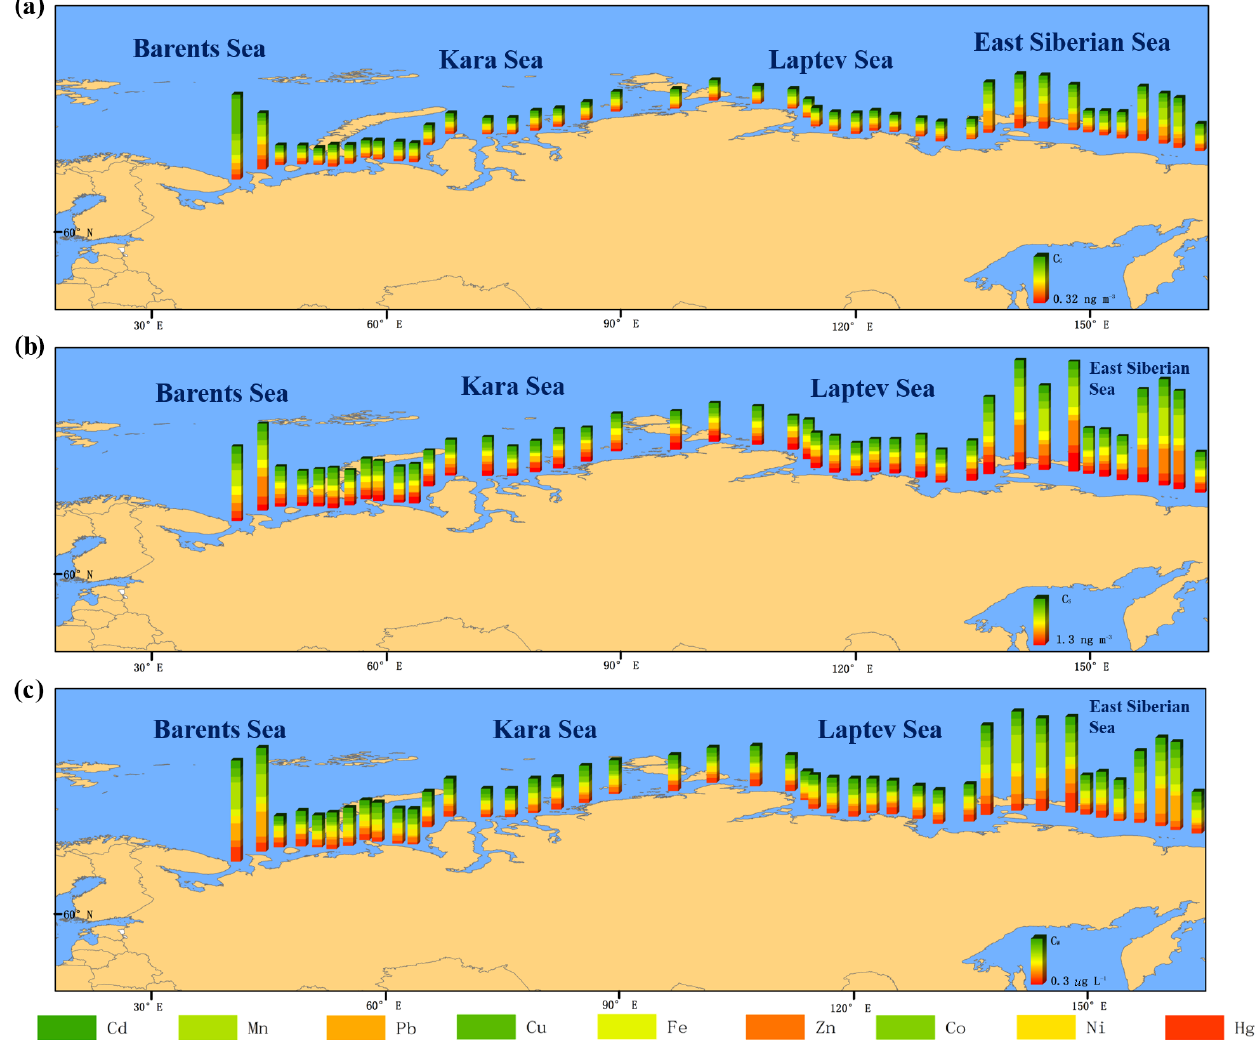
Figure 2. Occurrence of heavy metals. Results show the concentrations of heavy metals in the (a) gas phase, (b) aerosol phase, and (c) dis- solved water phase. Colored bars show the sum of nine quantified metals. The number at the bottom of the legend bars in the panels represent the concentration scale (and is the same for Figs.